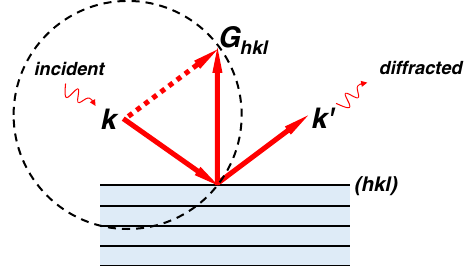
Fig. 1 | Illustration of Laue condition in a θ – 2 θ geometry. Only (hkl) planes perpendicular to the surface normal of the sample — with their corresponding reciprocal lattice vectors G hkl pointing out-of-plane — are able to generate a detectable diffracted X-ray in θ – 2 θ symmetric scans. k and k ’ are the wave vectors of the incident and the diffracted X-ray beams, respectively. The Ewald sphere is depicted by the dashed